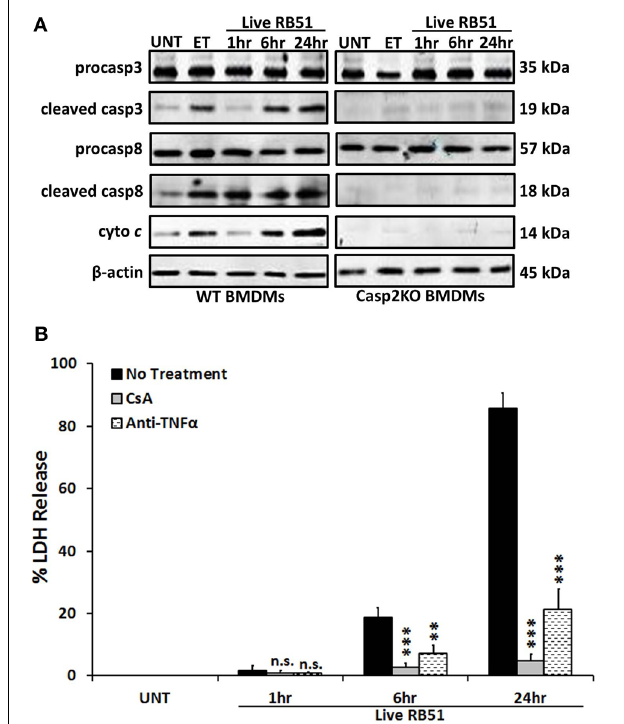
FIGURE 1 | Caspase-2 drives both the intrinsic and extrinsic cell death pathways. (A) caspase-3 and -8 cleavage (activation) as well as cytochrome c (cyto c ) release in Live RB51-infected WT and casp2 − / − BMDMs. β -actin served as a loading control. UT and ET represent untreated and etoposide (25 μ M, 6hr treatment), respectively. Immunoblots are representatives of n ≥ 3 independent experiments. (B) LDH release in Live RB51-infected RAW264.7 macrophages in the presence of cyclosporin A (CsA; inhibitor of mitochondrial permeability transition pore, 10 μ M) and Anti-TNF α (10 μ g/mL). Error bars represent mean ± SD of n ≥